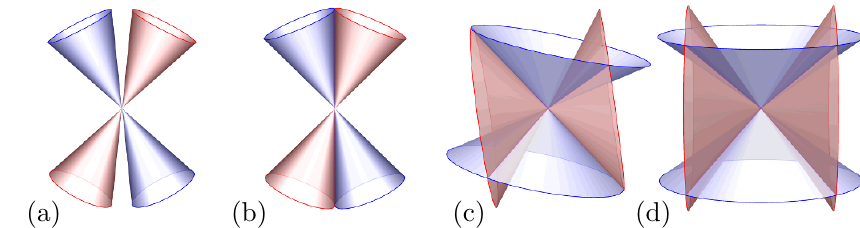
Figure 3 . Null cones that are neither causally nor null